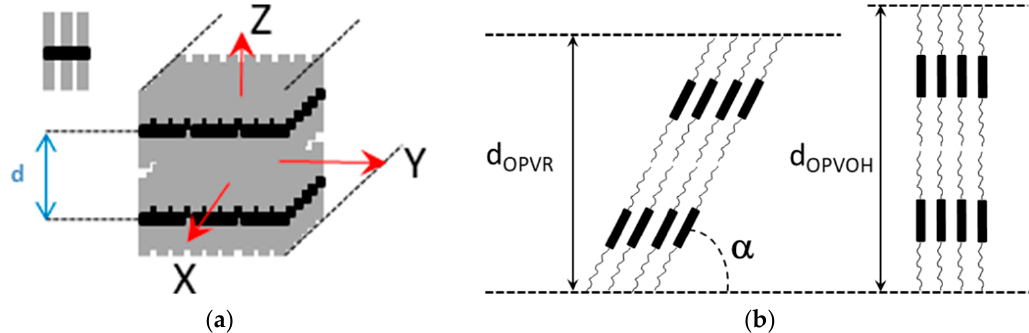
Figure 10. SAXS scattering: blue line is the diffraction patterns for OPVOH (Appendix Figure A1b), and red line for OPVR (Appendix Figure A1a) gels in benzyl alcohol [13]. Dashed lines stand for the fits of the different peaks with Equation (16).